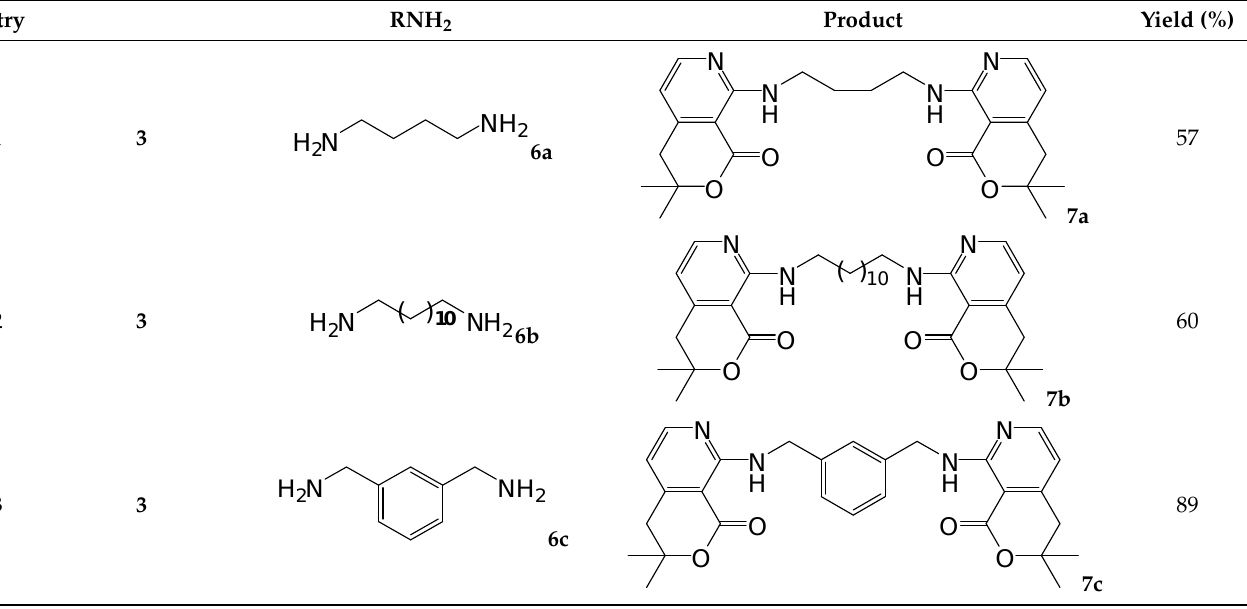
Table 2. Synthesis of bis-2-aminopyridine lactones.